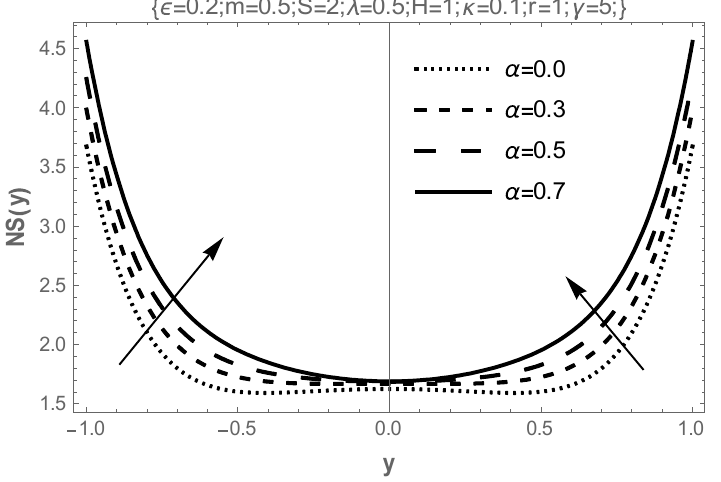
Figure 8. Effect of the porous permeability variation parameter on entropy profile.